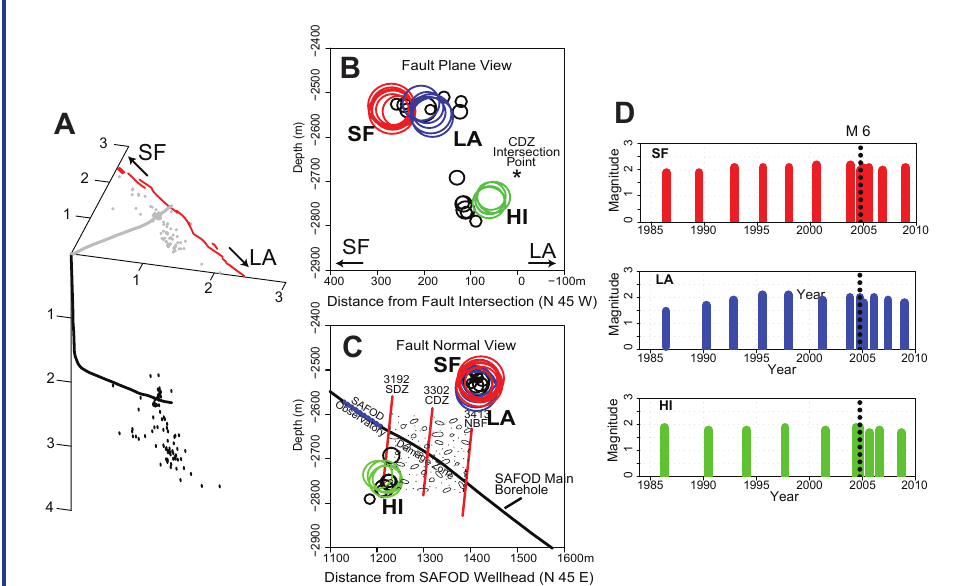
Figure 2. Microearthquakes selected for targeting with SAFOD. [A] 3-D perspective view of the seismicity with respect to the path of the SAFOD borehole, with north pointing up, east to the right, and depth down (all axes in km). [B] View of the plane of the San Andreas Fault at about 2.7-km depth looking to the northeast. The red, blue, and green circles represent seismogenic patches of the San Andreas Fault that produce nearly identical, regularly repeating microearthquakes termed the San Francisco (SF), Los Angeles (LA), and Hawaii (HI) clusters, respectively. The point at which the SAFOD borehole passes through the central deforming zone (CDZ) is shown by the asterisk. [C] Cross-sectional view of these earthquakes looking to the northwest, parallel to the San Andreas Fault, including the trajectory of the SAFOD borehole and the principal faults associated with the damage zone shown in Figs. 3 and 4. Note that the HI events occur about 100 m below the fault intersection at 3192 m (measured depth), indicating that the HI microearthquakes occur on the southwest deforming zone (SDZ). The SF and LA sequences occur on the northwest bounding fault (NBF), as discussed in the